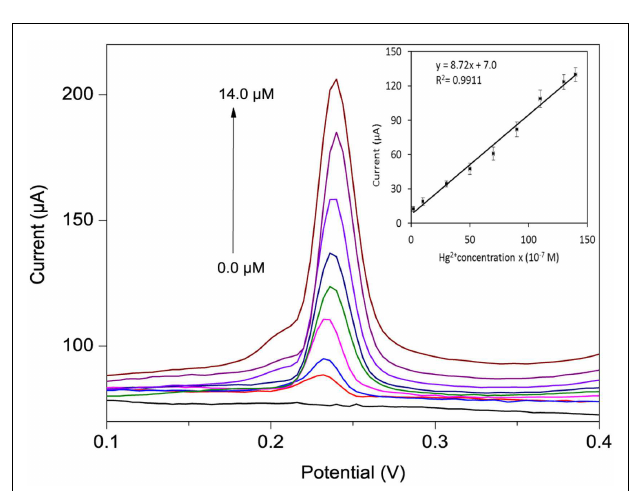
FIGURE 10 | DPSV curves for different Hg 2 + concentrations (0, 0.2, 1.0, 3.0, 5.0 7.0, 9.0, 11.0, and 14.0 µ M) in 0.05M HNO 3 using po-Gr/PEDOT:PSS-modified GCE (inset shows calibration plot of peak current vs. Hg 2 + concentration).The reduction voltage is − 0.30V vs. Ag/AgCl for 120s, then DPSV stripping in the range − 0.2 to 0.8V vs. Ag/AgCl at increments of 4mV, amplitude 0.05V, pulse width 0.2s, and pulse period